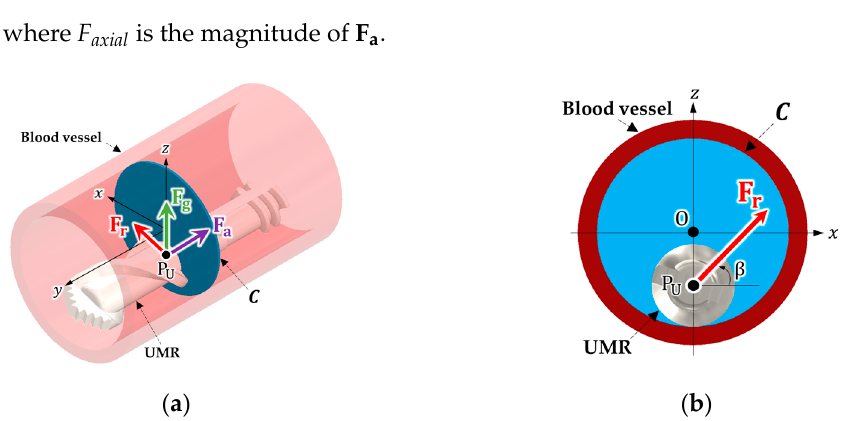
Figure 5. ( a ) Magnetic forces applied to the UMR ( F g , F r , and F a ); ( b ) magnetic force F r applied to the radial direction of the blood vessel and the angle β between F r and the X-axis of the blood vessel.